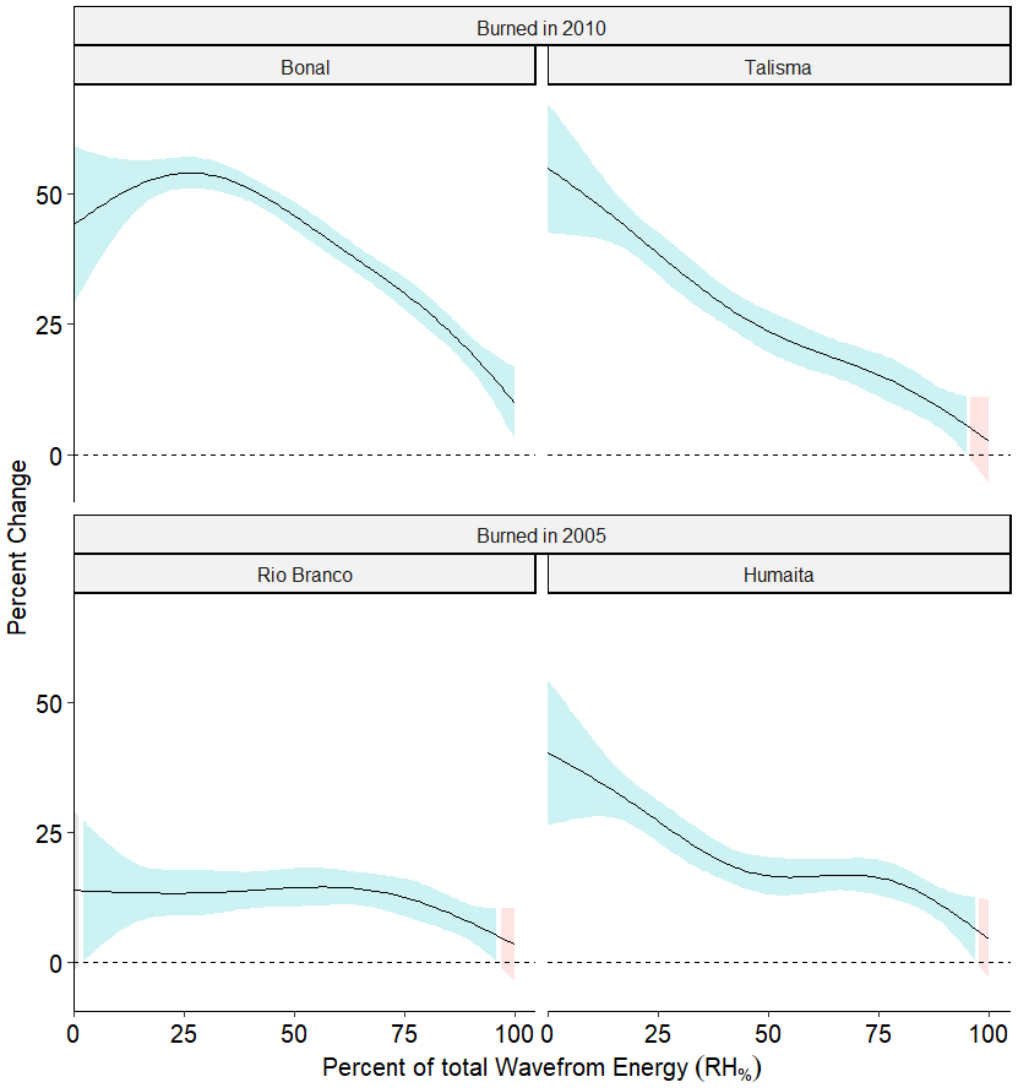
Figure 8. Percent change as measured by the difference between GAM trend lines divided by the mean height of unburned forest at each relative height step throughout the canopy for the four different sites. Band color indicates significance as measured by whether the CI overlaps 0 and blue indicates significant differences, while red indicates no significant difference.